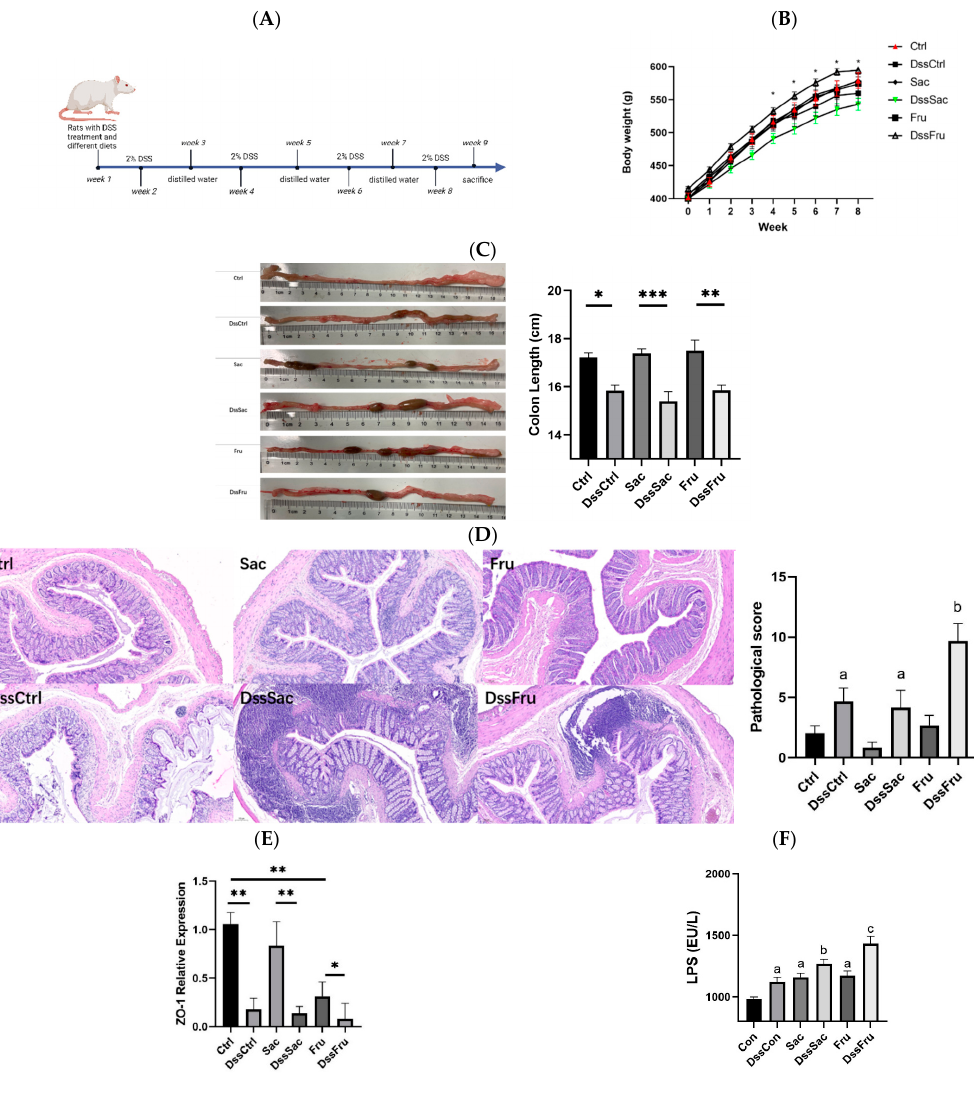
Figure 1. The addition of sugar, especially fructose, promoted the symptoms of DSS-induced colitis in rats by decreasing ZO-1 expression and increasing LPS levels. ( A ) Animal experimental design; ( B ) body weight of different groups (n = 10); ( C ) colon length appearance and statistical analysis ( n = 6); ( D ) colon H&E staining (100 × ); ( E ) relative expression of ZO-1 (n = 6); ( F ) LPS level in serum, n = 8. Data represent the following: means ± SEM, * p < 0.05, ** p < 0.01, *** p < 0.001. Different letters indicate a significant difference, p <